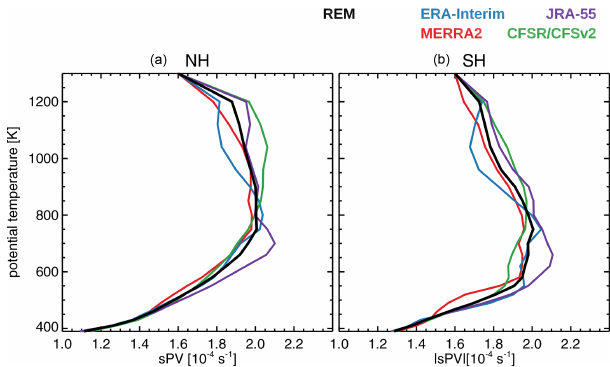
Figure 10. sPV vortex definition for each reanalysis as well as for the REM. These were constructed using climatological values from 1980–2014